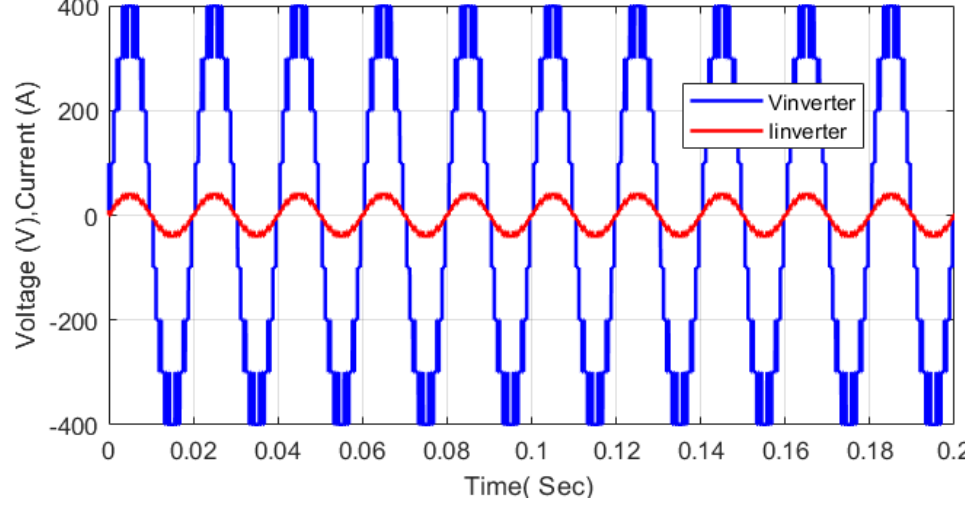
Figure 25. Nine-level output voltage of the proposed topology.